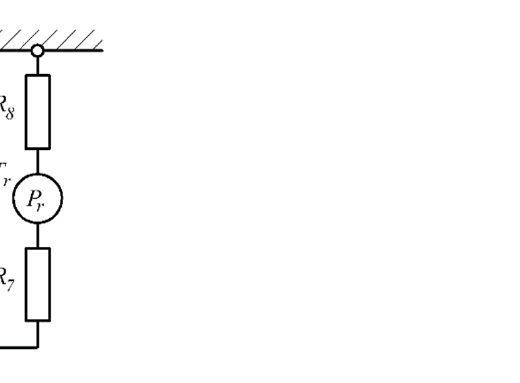
Figure 5. Thermal equivalent circuit of the EMM with independent dual circuit liquid cooling.